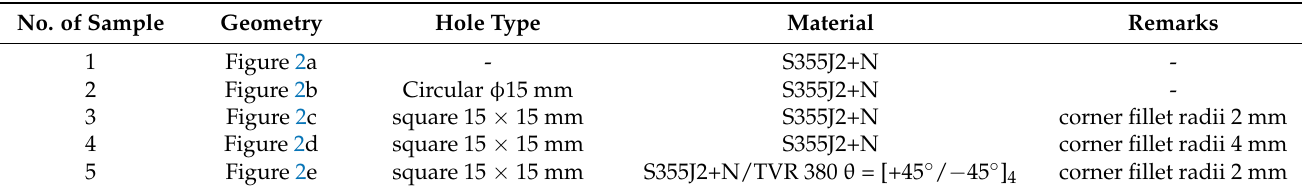
Figure 2. Geometry and dimension of tested samples made of: ( a ) S355J2+N; ( b ) S355J2+N with circular hole; ( c ) S355J2+N with rectangular hole with fillet radius R2; ( d ) S355J2+N with rectangular hole with fillet radius R4; ( e ) S355J2+N with rectangular hole with fillet radius R2 with reinforcement overlays made of TVR 380 with layer orientation [+45 ◦ / − 45 ◦ ] 4 . Table 3. Description of investigated samples.